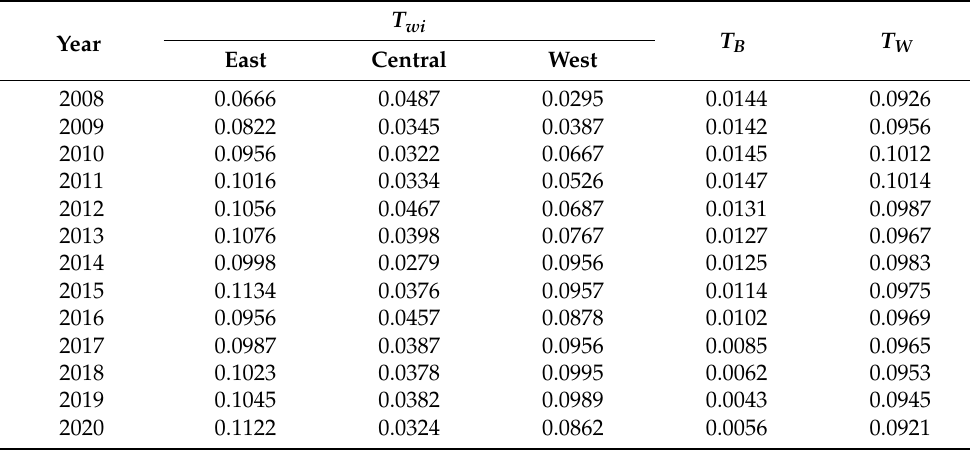
Table 5. Decomposition results of Theil index of transportation CEE in three regions in